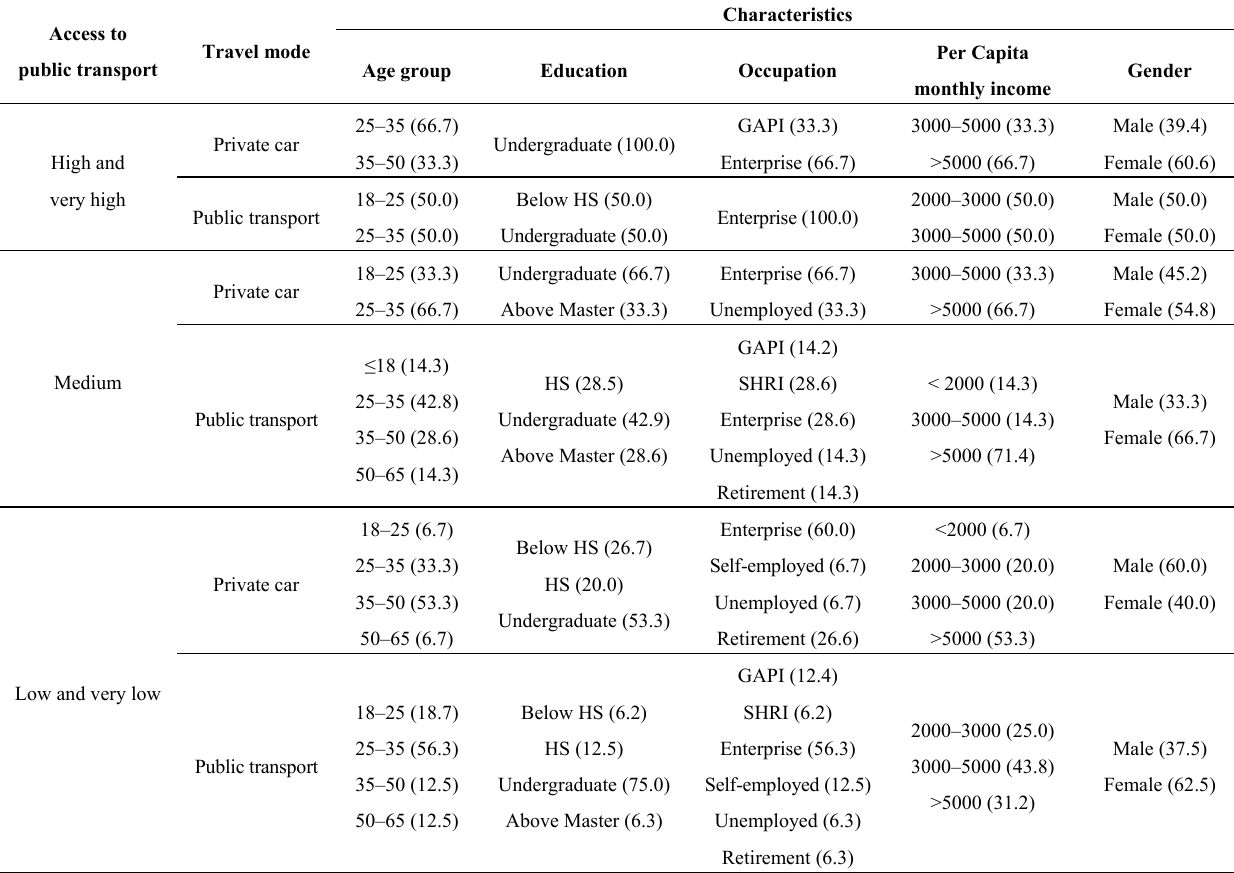
Table 4. Characteristics of car owners on weekdays